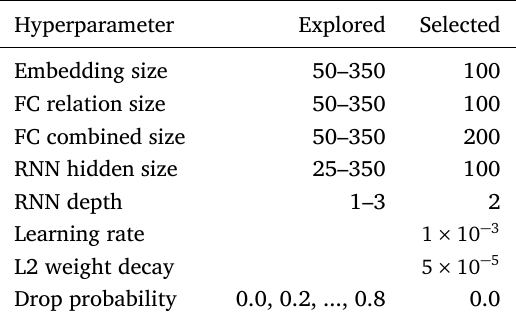
Hyperparameters in the